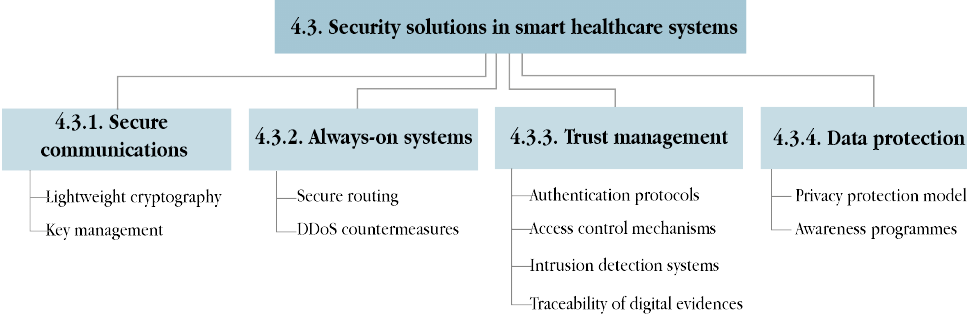
Figure 6. Taxonomy of security solutions in smart healthcare